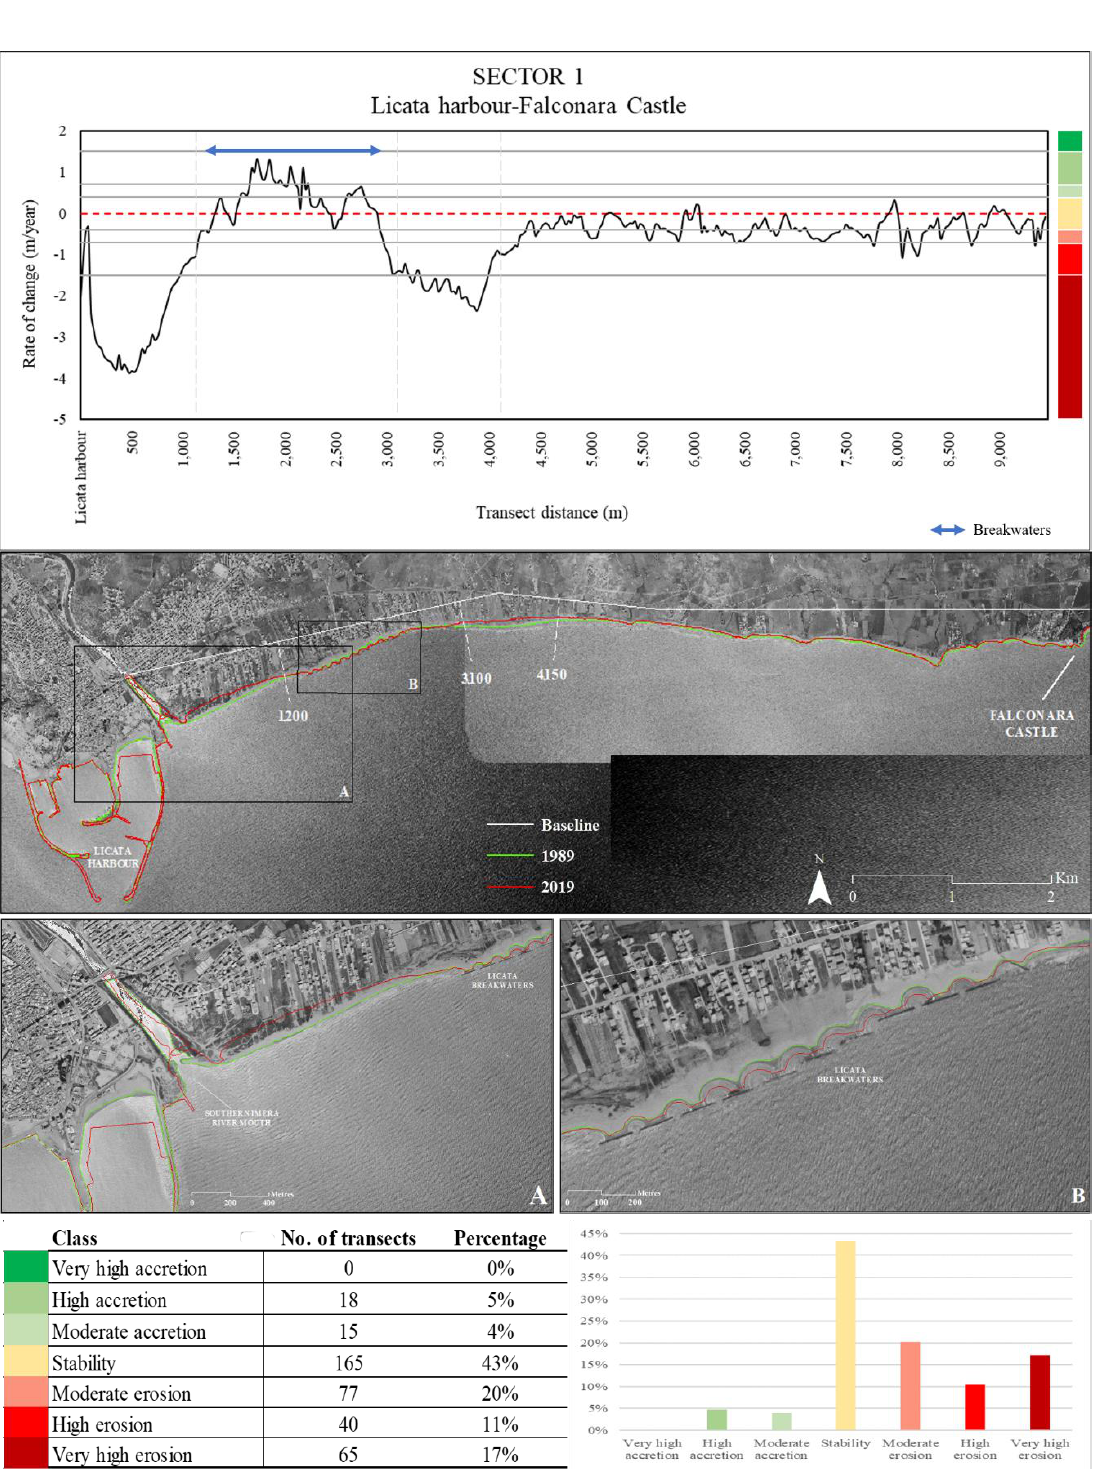
Figure 6. Shoreline changes over the mid-term period (1989–2019) within sector no. 1. Sector no. 1 is about 10 km long, from the Licata harbour to the Falconara Castle, but the rate-of-change plot indicated that the highest variability was detected within 4 km eastward of the Licata harbour. ( A ) The most severe erosion phenomena occurred right next to the Southern Imera River mouth; ( B ) accretional classes have been recorded about 1.2 km eastward the Licata harbour where 11 breakwaters have been emplaced to block the intense sediment loss. Grey dashed lines are those transects cast by the DSAS and delimit coastal areas that have recorded main